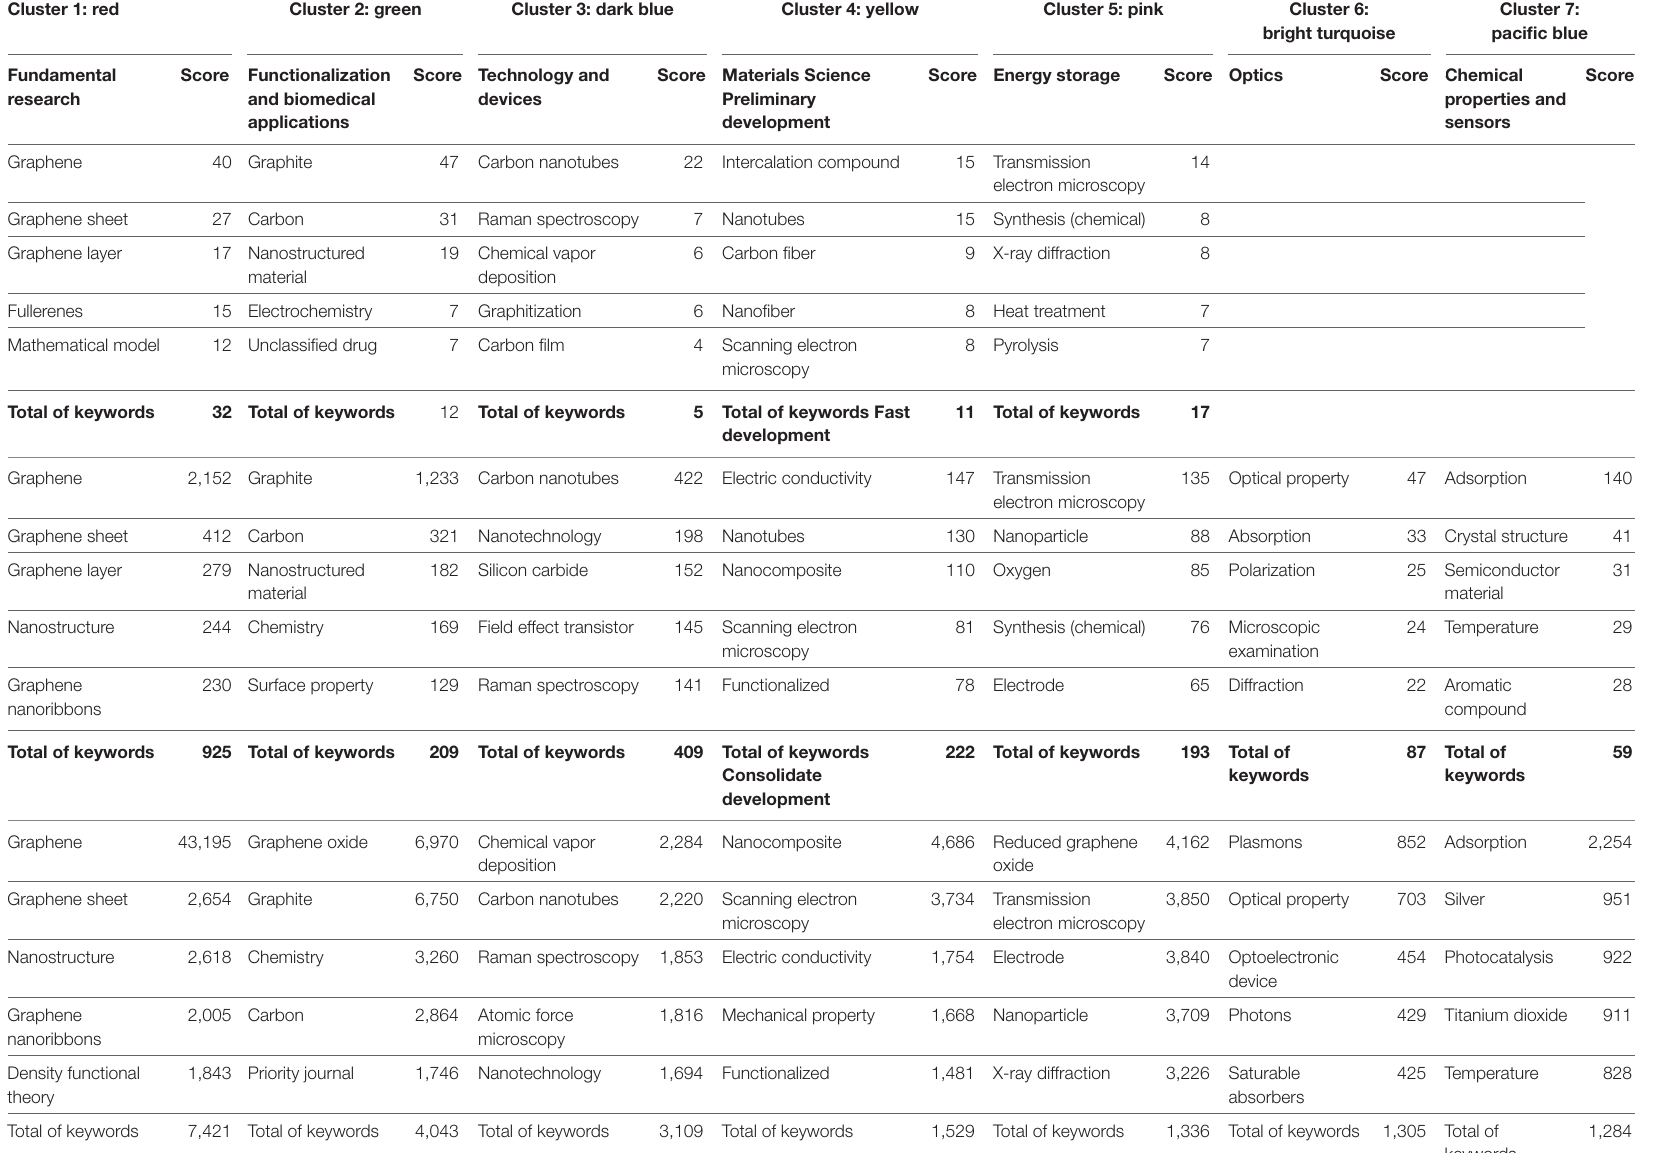
TaBle 4 | Longitudinal study of the research lines and most frequent keywords in the world. cluster 1: red cluster 2: green cluster 3: dark blue cluster 4: yellow cluster 5: pink cluster 6: